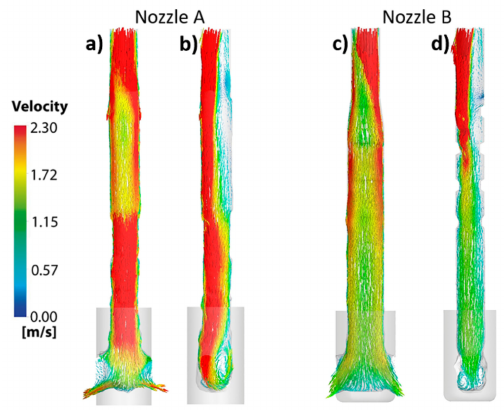
Figure 21. Numerical velocity fields in the nozzles with clogging. ( a ) Longitudinal plane axis of symmetry of nozzle A. ( b ) Longitudinal plane axis of symmetry of nozzle A at 90 ◦ . ( c ) Longitudinal plane axis of symmetry of nozzle B. ( d ) Longitudinal plane axis of symmetry of nozzle B at 90 ◦